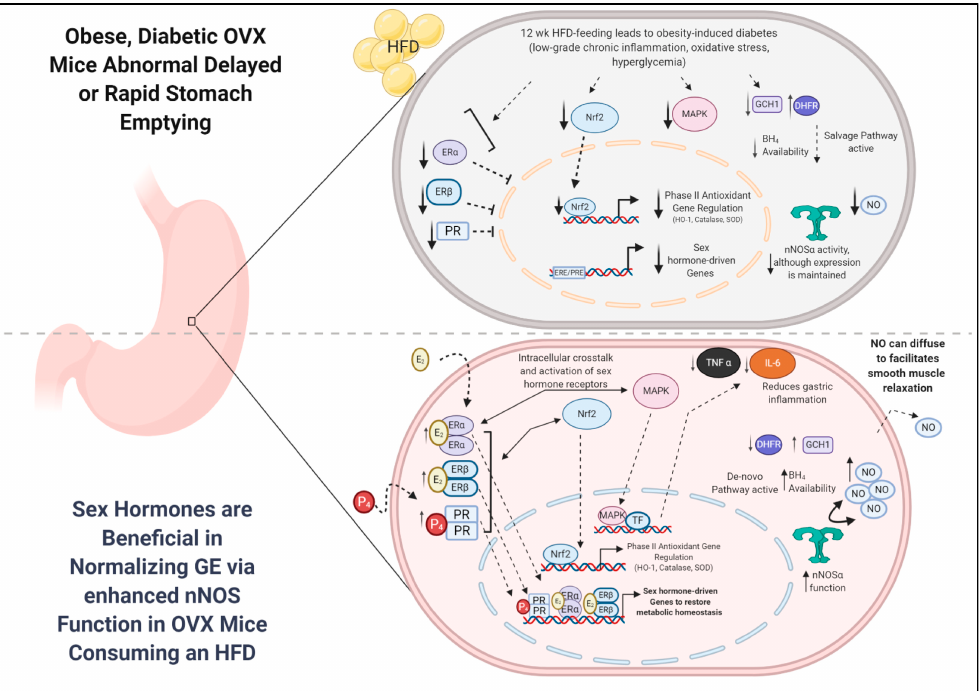
Figure 7. Schematic illustration depicting the hypothesized effects of 17 β -Estradiol (E 2 ) and Progesterone (P 4 ) on mechanistic signaling of Sex hormone receptors on Nrf2, MAPK, and nNOS mediated gastric motility and gastric emptying in obesity/T2D female mice. We speculate that the sex hormone-depleted (OVX) gastric milieu may exhibit compensatory mechanisms to facilitate faster GI motility when consuming a daily HFD. Perhaps a gastrointestinal (GI) system devoid of ovarian sex hormones (chronic OVX) displays gradual changes in ER, Nrf2, and MAPK signaling in the gastric smooth muscle and enteric neurons to possibly “rewire” the female gut. The supplementation of sex hormones, E 2 and P 4 , restored not only systemic and gastric fitness through restoration of proinflammatory pathways but also nNOS and its essential BH4 cofactor expression to normalize GE rates in obese, diabetic mice consuming a daily HFD.